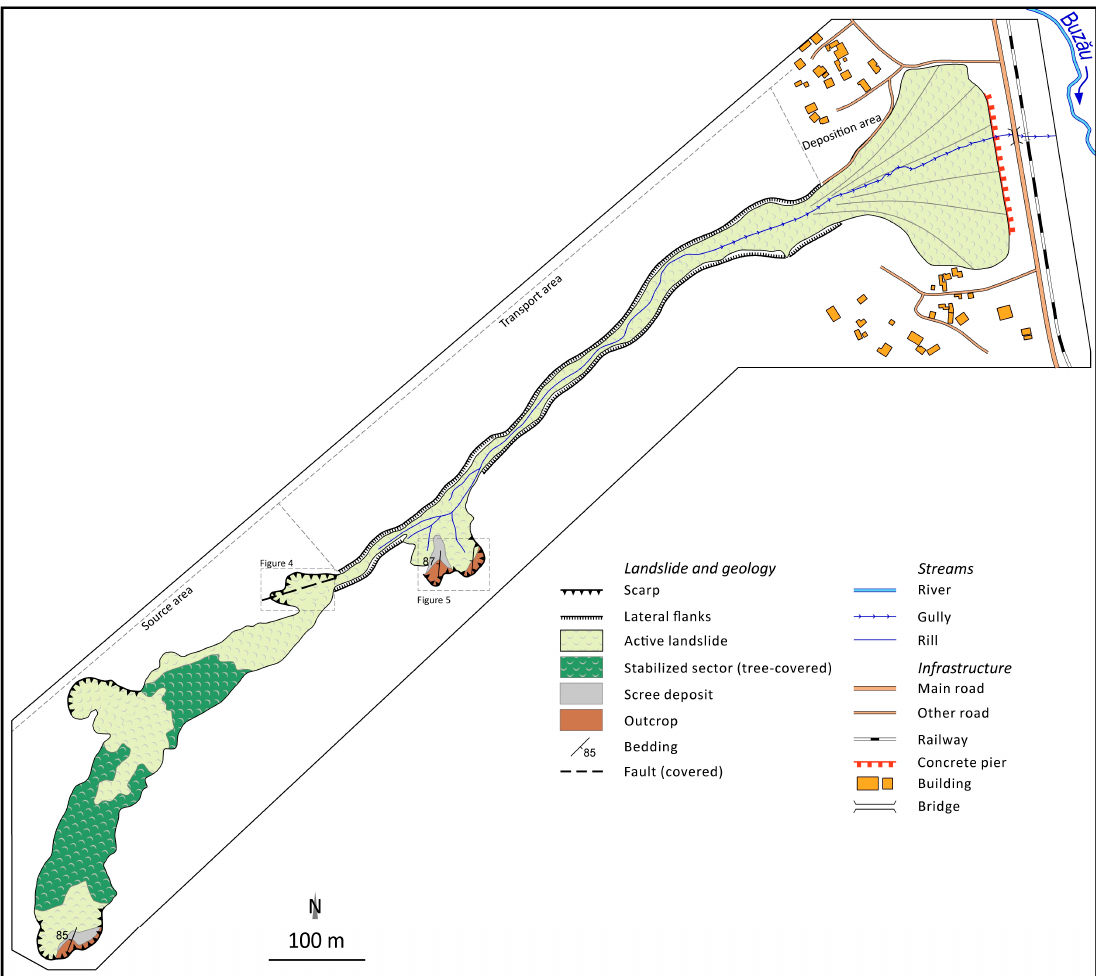
Figure 3. Geomorphological sketch of the Chirle ș ti earth fl